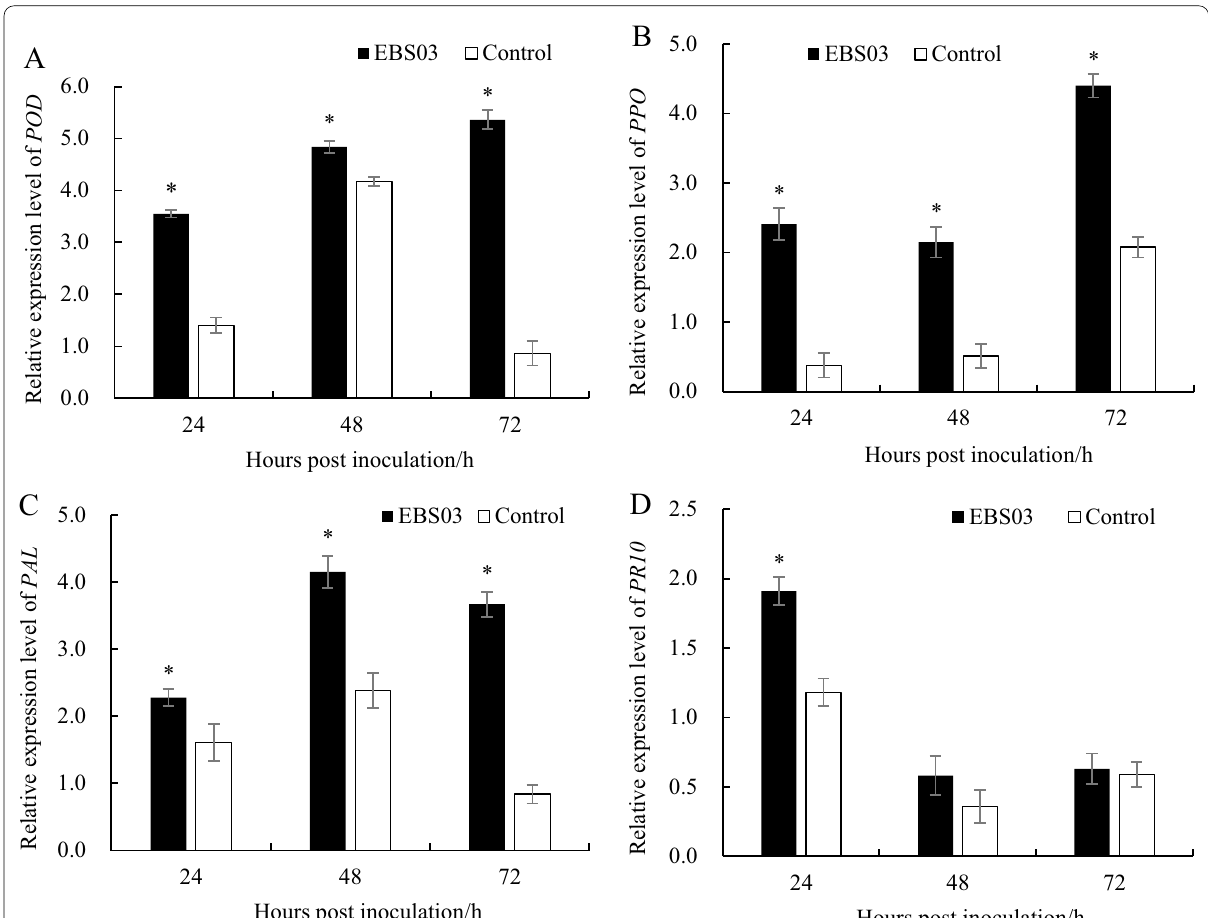
Fig. 8 EBS03 induced the expression level of defense-related genes in cotton. A – D expression level of POD , PPO , PAL , and PR10 in cotton with EBS03 treatment or not. * indicates a significant difference at the 0.05 probability level ( P < 0.05 )